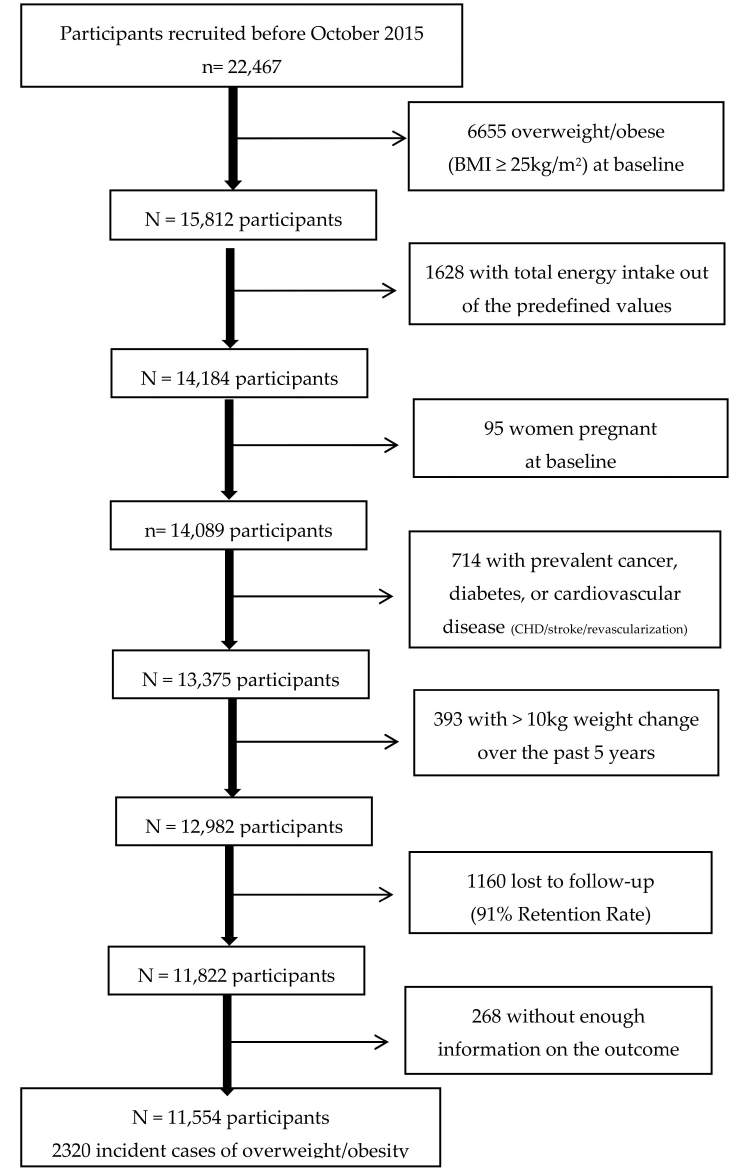
Figure 1. Flow chart depicting the selection process among participants of the Seguimiento Universidad de Navarra (SUN)